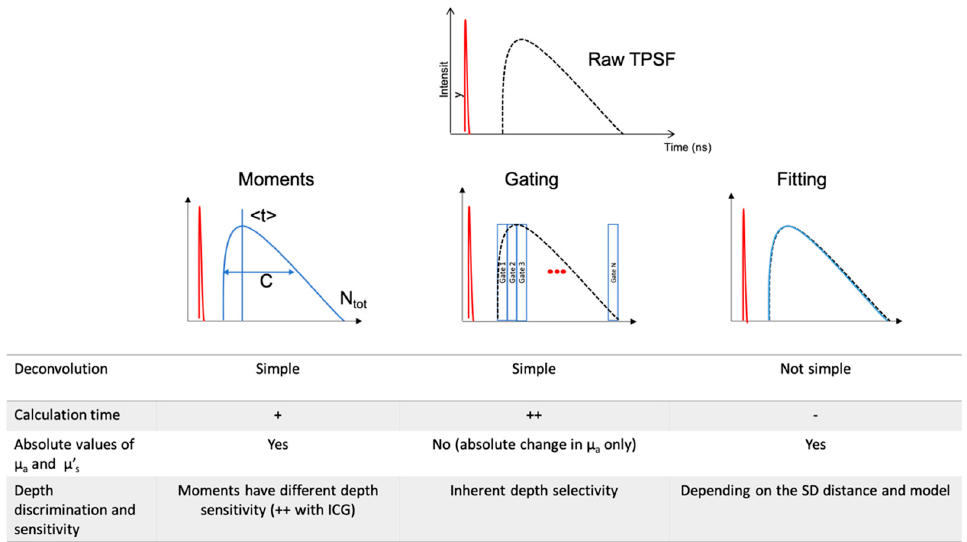
Figure 2. Schematic of the three-data processing approach in TD-NIRS.